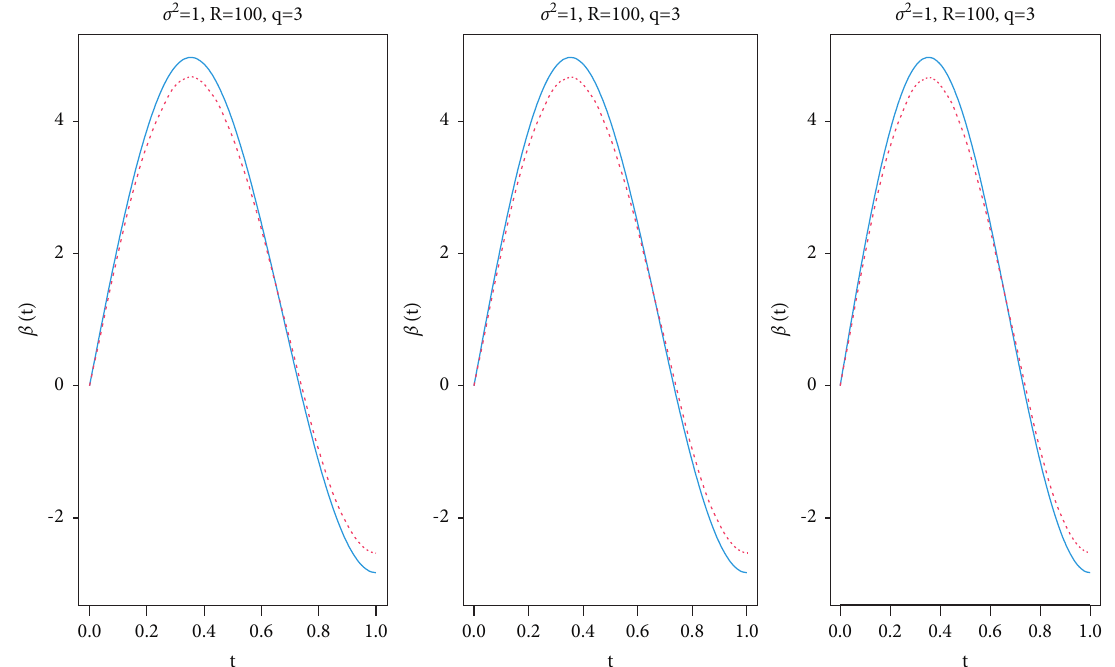
Figure 4: The estimated functional coefficient versus true value of β ( t ) with different ρ s (from left to right responding to ρ � 0 . 5 , 0 , − 0 . 5) when R � 100 ,q � 3 , and σ 2 �